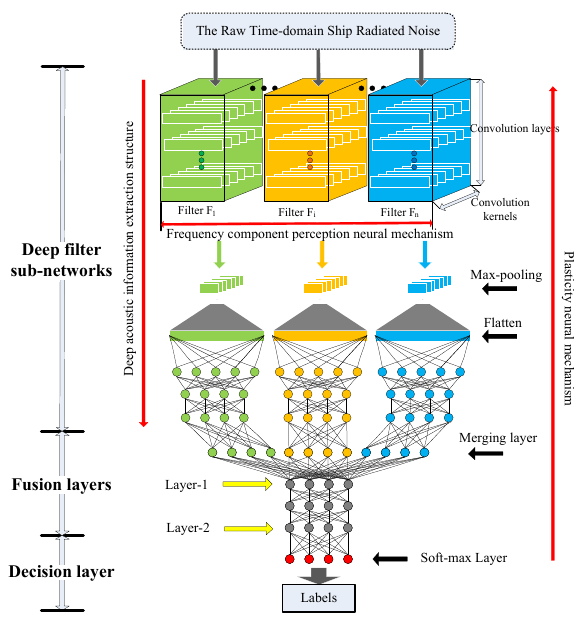
Figure 1. The architecture of